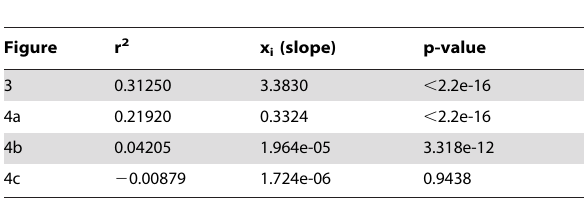
Table 3. Pedestrian flow correlation Matrix for all locations. Table 4. Summary of the linear regression analysis.